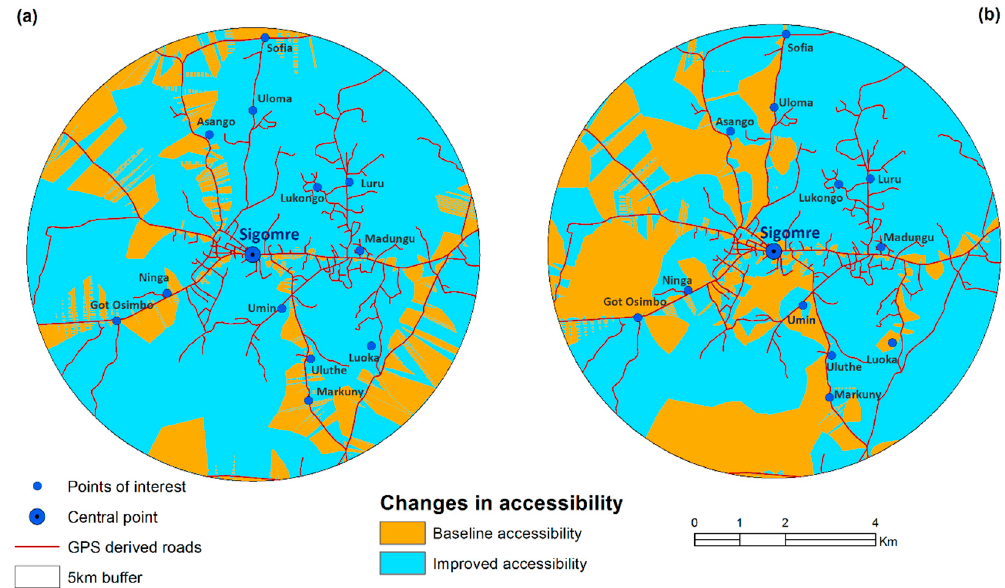
Figure 8. Potential improvement in estimation of accessibility were the GPS data from motorcycle taxis to be combined with ( a ) official roads and ( b ) OSM data. The orange parts depict the areas whose accessibility was estimated accurately based on baseline data, while the areas in blue color shows areas whose accessibility improved when estimated from the GPS-derived road networks.